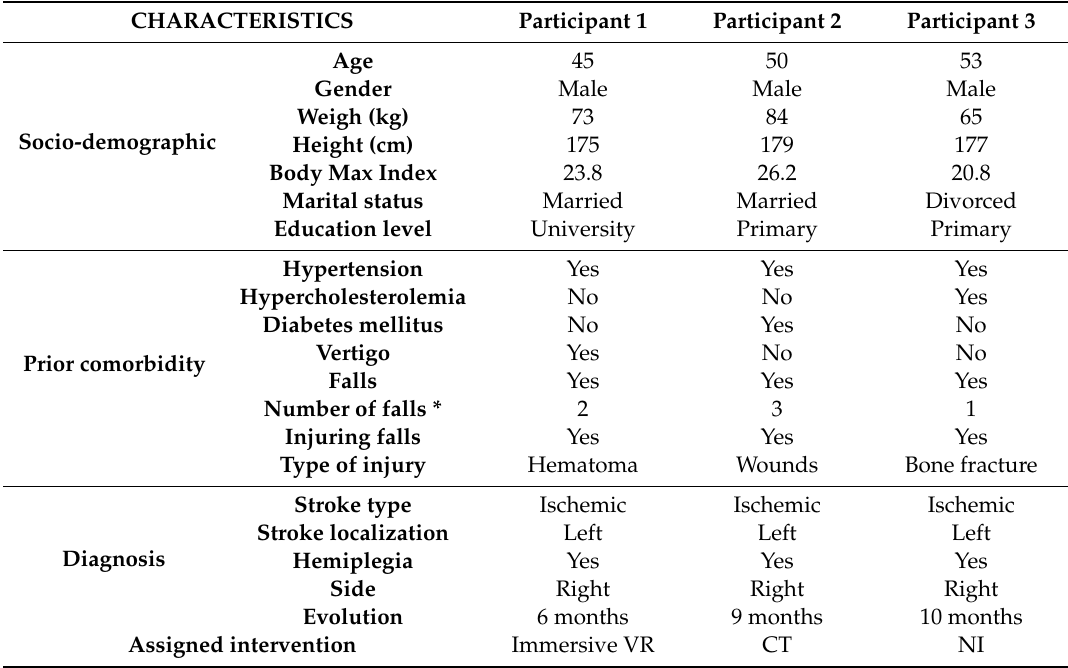
Table 1. Main characteristics of patients included in the